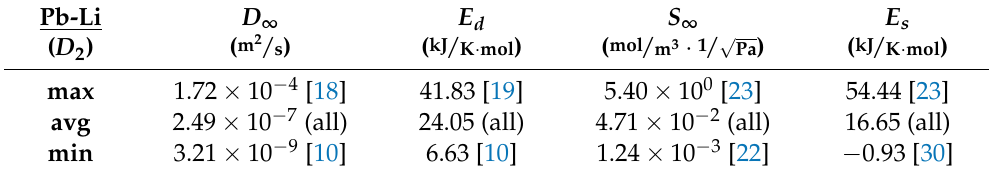
Table 3. Average and extreme values of dissolution parameters for deuterium in Pb-Li [11,18,20,22–35].